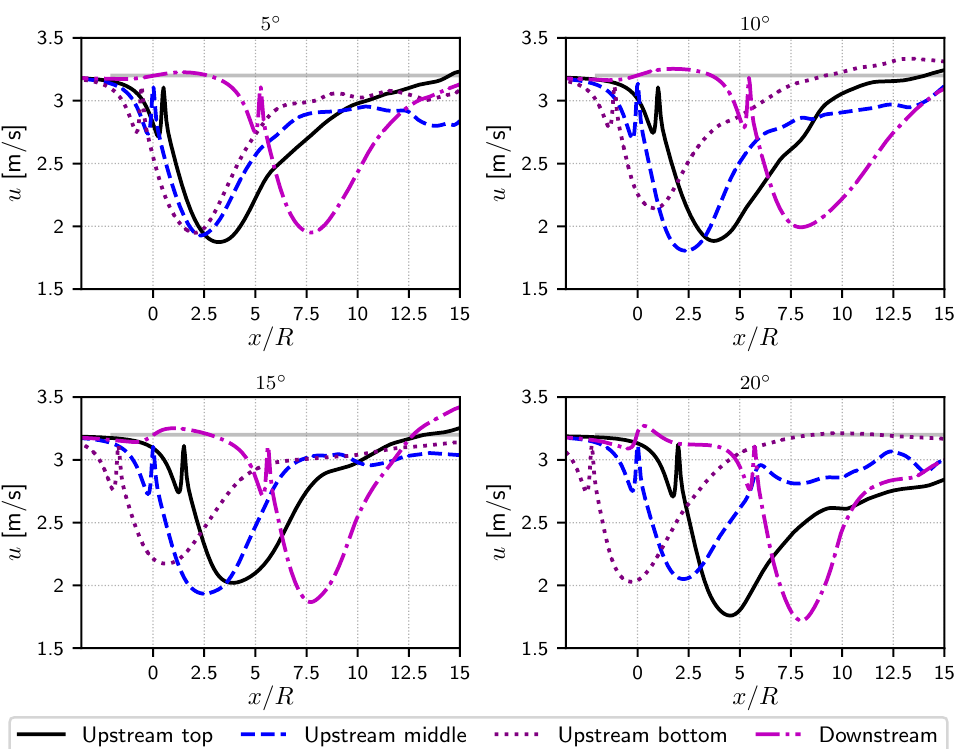
Figure 15. Time-averaged wake lines obtained for four yaw angles ( I ∞ = 10%, L = 18 m, Rf ≈ 229, TSR = 4.1, σ ( λ ) = 75%). For each turbine, the corresponding line passes through its centre. The solid grey line depicts the incoming velocity U ∞ = 3.2